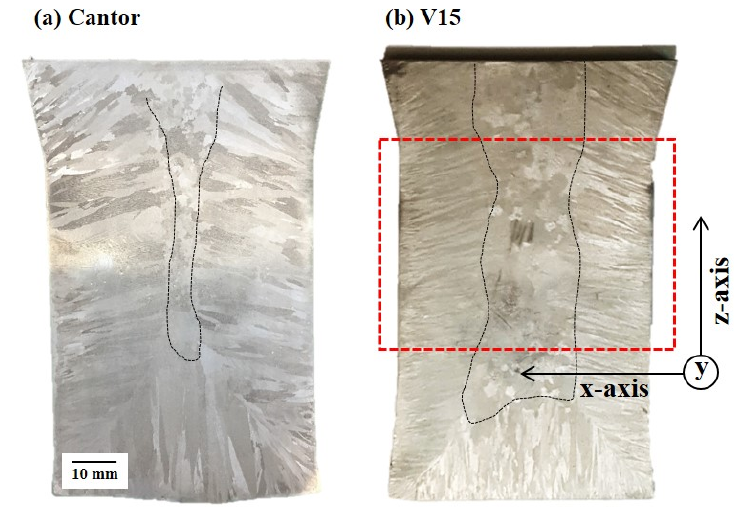
Figure 4. Macrostructures of the ( a ) Cantor alloy and ( b ) V15 HEAs. Tensile specimens were prepared at the center of each material, indicated by the red dotted line, along the three different loading directions plotted in Figure 4b. The x ‐ axis is parallel to the columnar structure.